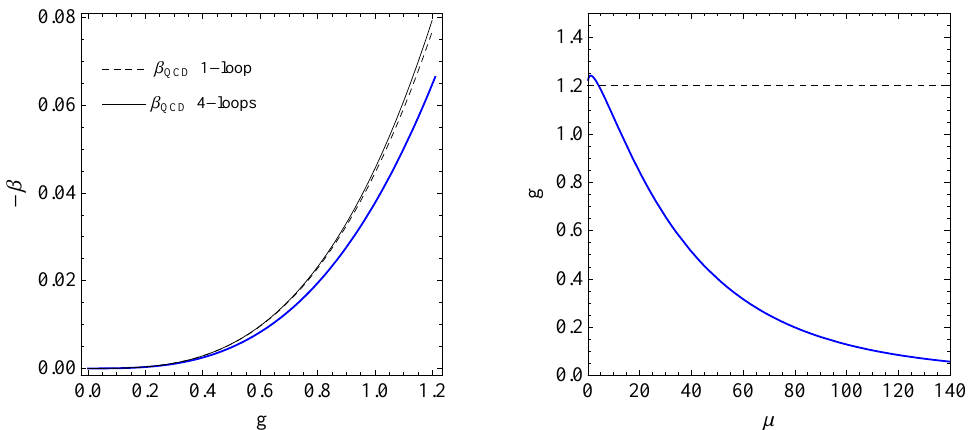
Figure 3. Left panel: Behavior of beta function against effective coupling, as given by Equation (30). We display also the result from Quantum Chromodynamics (QCD) in one-loop [3] and four-loop [25] approximation. Right panel: Effective coupling as a function of the scale µ , as calculated by Equation (29). Taken from ref.